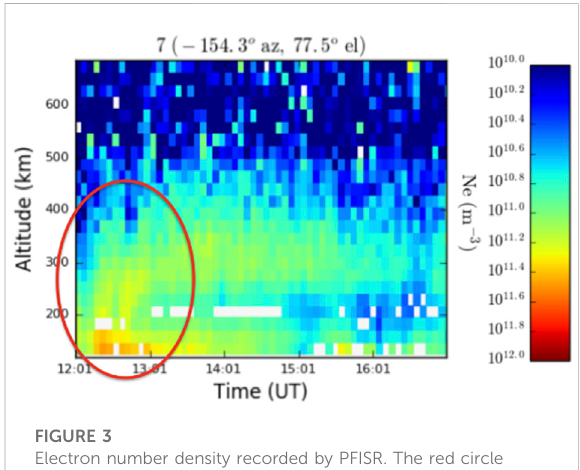
FIGURE 3 Electron number density recorded by PFISR. The red circle highlights a “ plume ” of ionization which is seen rising from lower altitudes close to the start of the pulsating